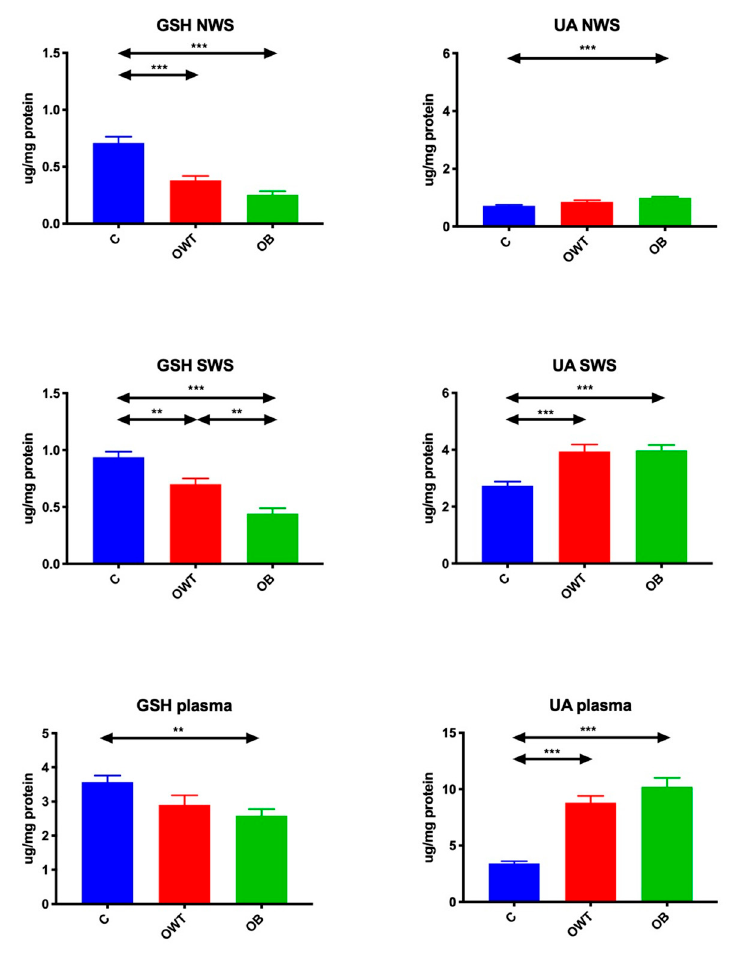
Figure 3. Non-enzymatic antioxidants in overweight and obese adolescents as well as healthy controls. C- control, GSH- reduced glutathione, NWS- non-stimulated whole saliva, OB- obese, OWT- overweight, SWS- stimulated whole saliva, UA- uric acid. Differences statistically significant at: ** p < 0,005, *** p < 0,0005.